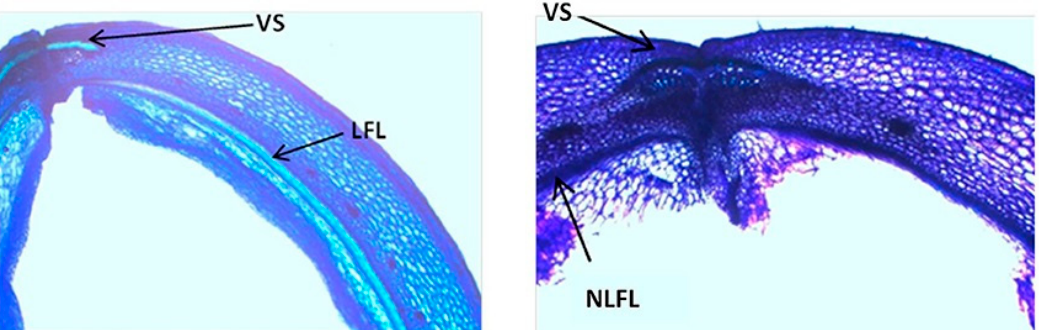
Figure 6. Representative light microscopy with toluidine blue O staining to illustrate differences between pod valves from the highly shattering line MG38 ( left ) and indehiscent variety Midas ( right ). Details show degree of lignification of ventral sheath (VS) and inner layer of the sclerenchymatic cells of the pod wall. LFL, lignified fiber layer; NLFL, nonlignified fiber layer. (reproduced with permission from Murgia et al. [27]; with modifications).